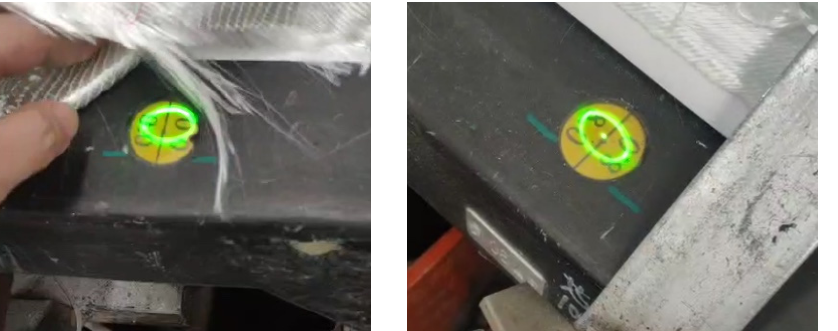
Figure 13. Projection errors occur.